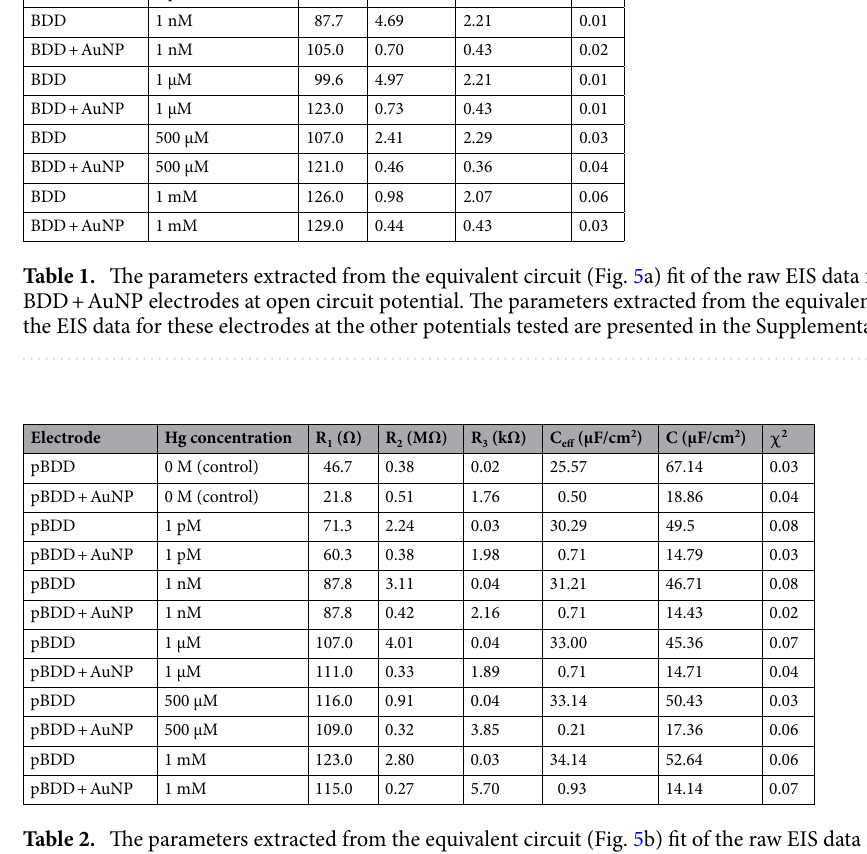
Table 2. The parameters extracted from the equivalent circuit (Fig. 5b) fit of the raw EIS data for the pBDD and pBDD + AuNP electrodes at open circuit potential. The parameters extracted from the equivalent circuit fit of the EIS data for these electrodes at the other potentials tested are presented in the Supplementary Information.